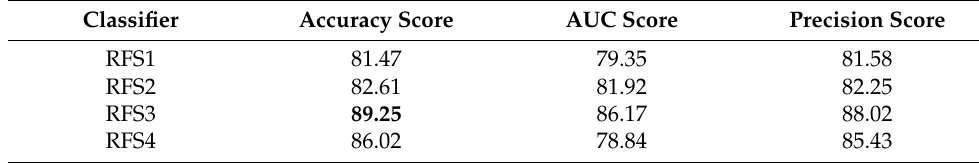
Table 5. Seasonal accuracy assessment of